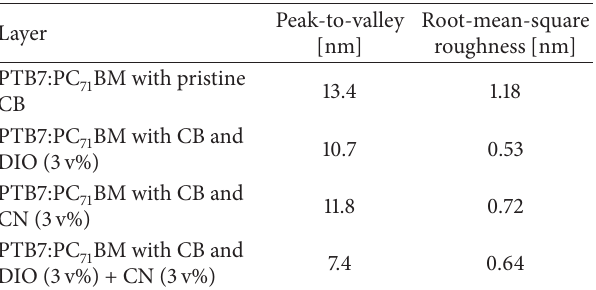
Table 4: Surface roughness parameters of the PTB7:PC layer obtained from AFM